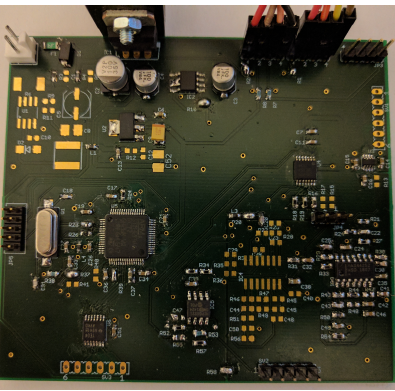
Figure 7 DSP Multi-sensor Board